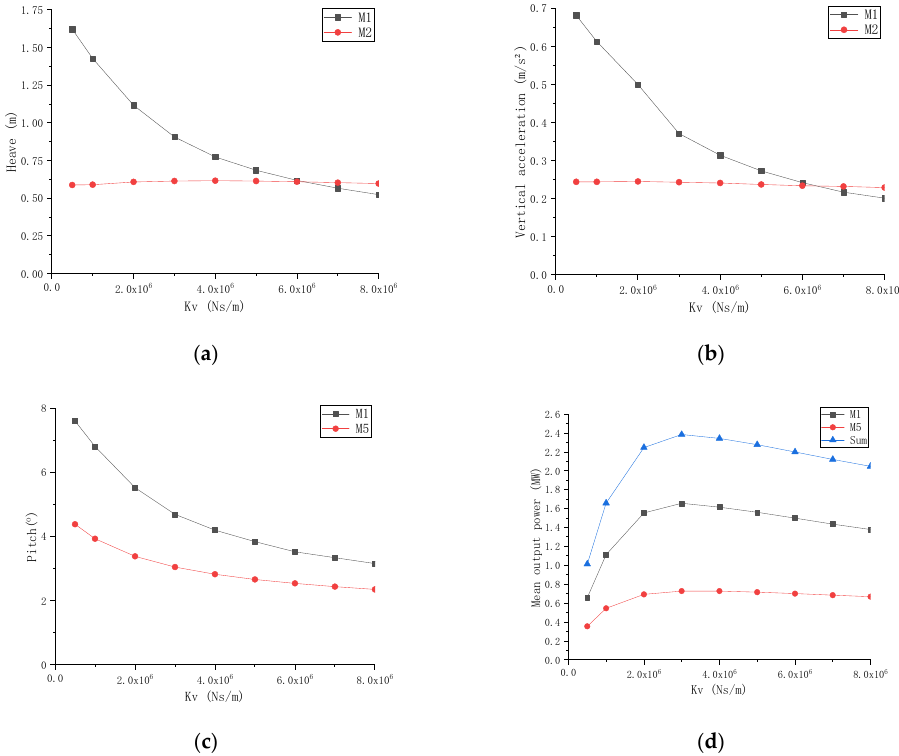
Figure 5. Horizontal dynamic responses and the mean output power with different K h : ( a ) surge; ( b ) horizontal acceleration; and ( c ) mean output power.